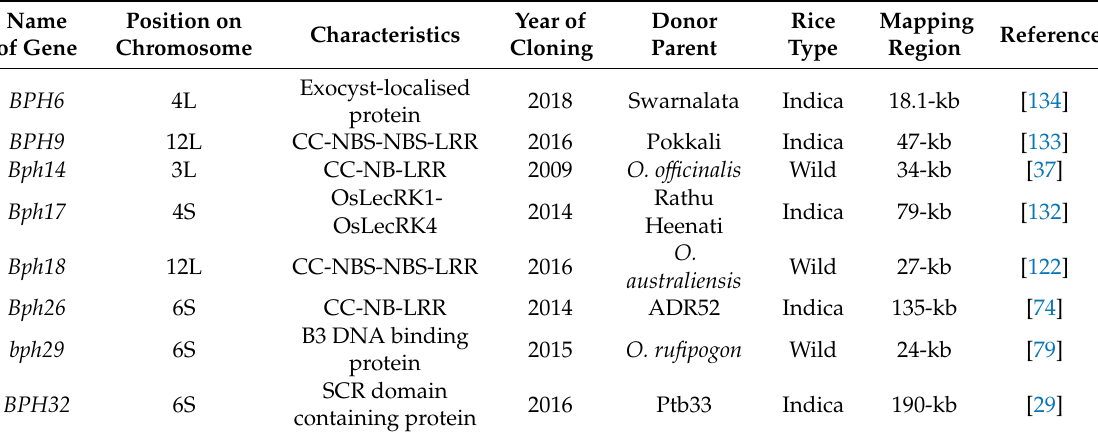
Table 4. Successfully cloned BPH resistance